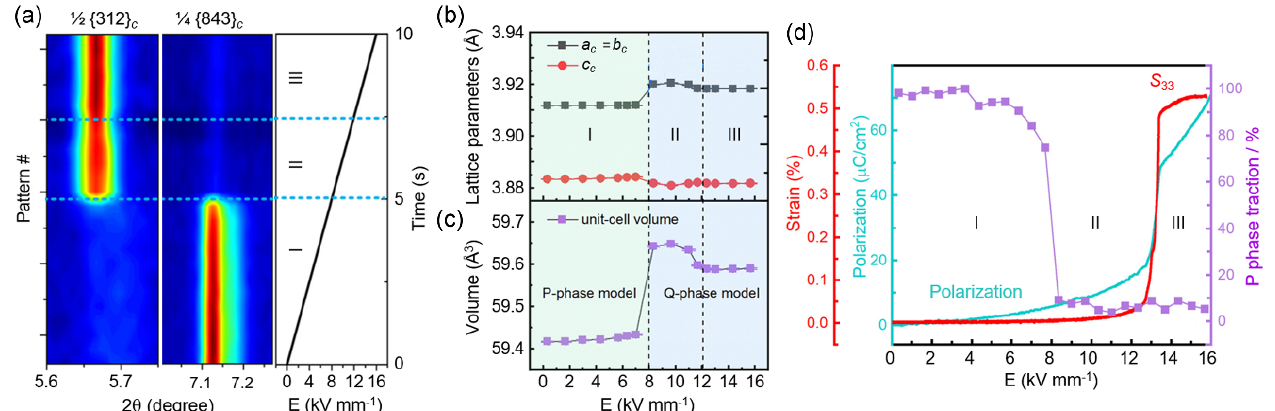
Figure 6. Time-dependent phase transition in NaNbO 3 under excitation of electric field. ( a ) Evolution of XRD superlattice reflections with increasing electric field for the AFE P (stage I) and FE Q (stage III) phases. ( b,c ) Pseudocubic lattice parameters and unit cell volume plotted as a function of electric field amplitude. ( d ) Evolution of the P-phase fraction, macroscopic polarization and longitudinal strain S 33 as a function of electric field [126]. Instead of the decoupled polarization switching process, stage II may also be interpreted as the emergence of an intermediate FiE phase.